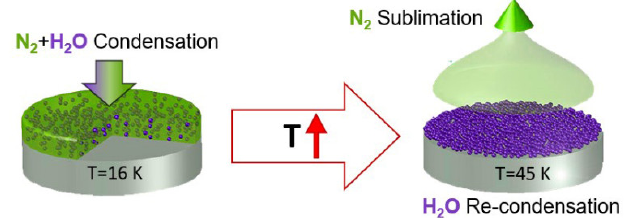
Figure 1. The scheme of the process of recondensation.